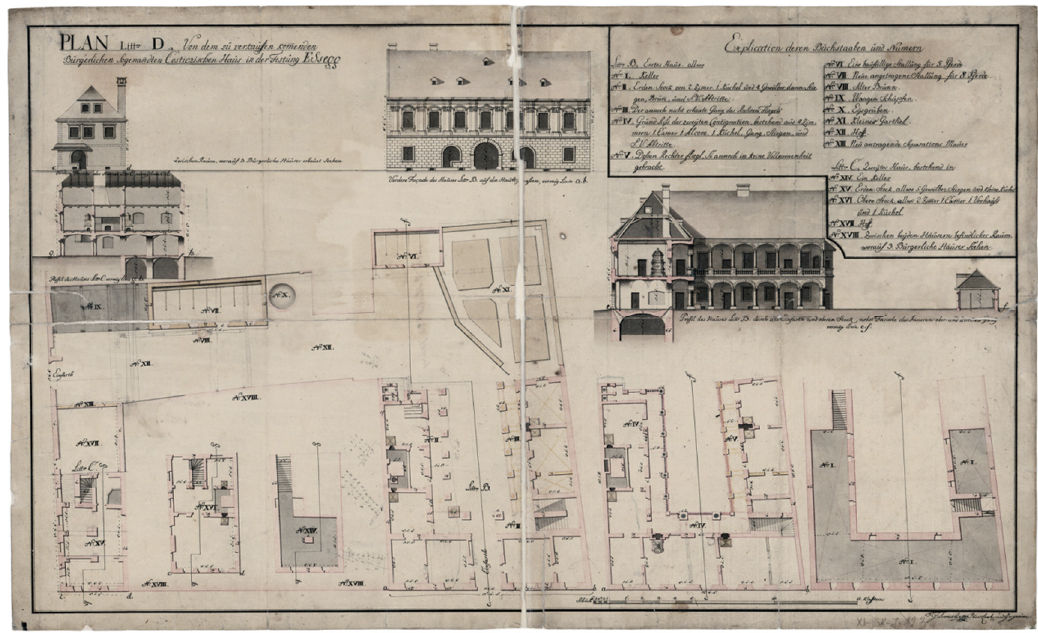
Figure 15. Architectural drawings of Kostić houses in 23 Kuhačeva Street from the 1774 [27].